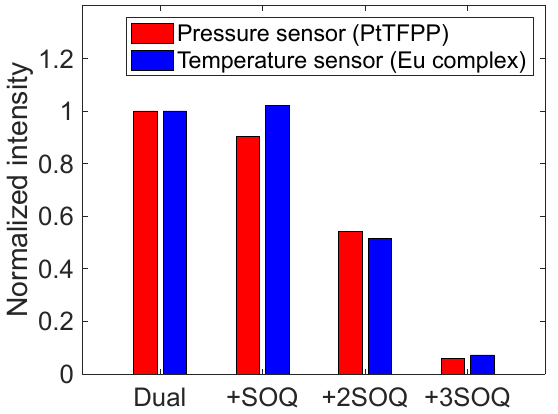
Figure 7. Effects of SOQ concentration on luminescence